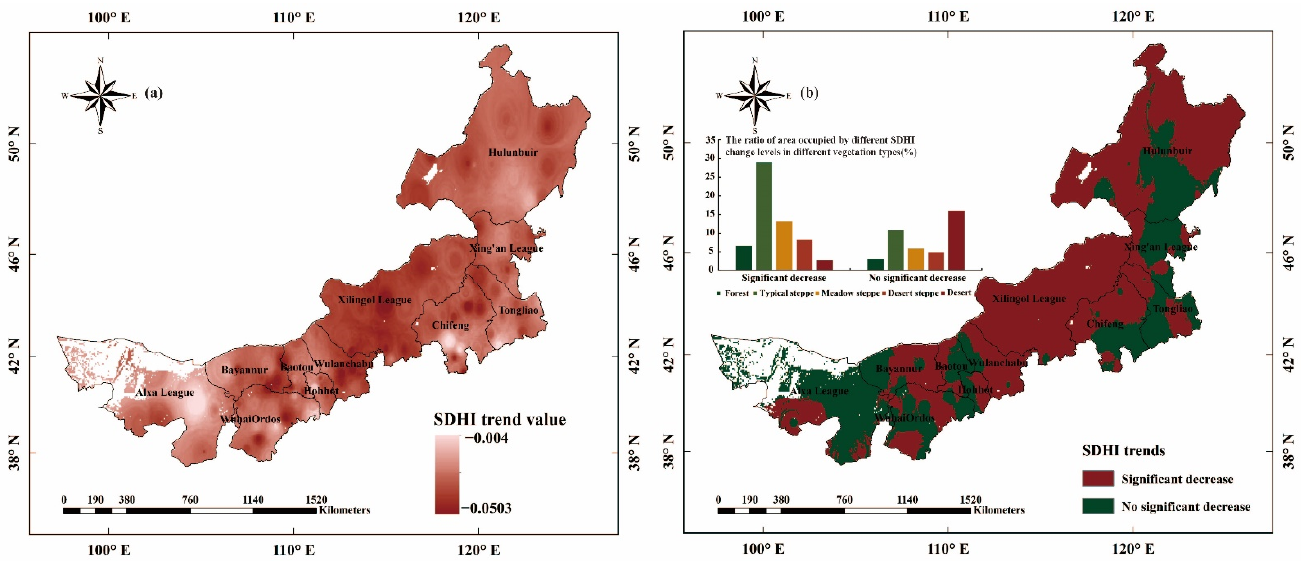
Figure 4. Spatial distribution of SDHI trends in Inner Mongolia from 1982 to 2020. ( a ) SDHI trend value, ( b ) multi-year average SDHI trend levels.